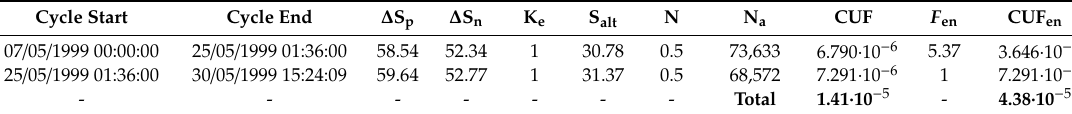
Table A3. Calculations performed to derive CUF and CUF en in the first sequence of real transients. ∆ S p : total stress range in the pair;